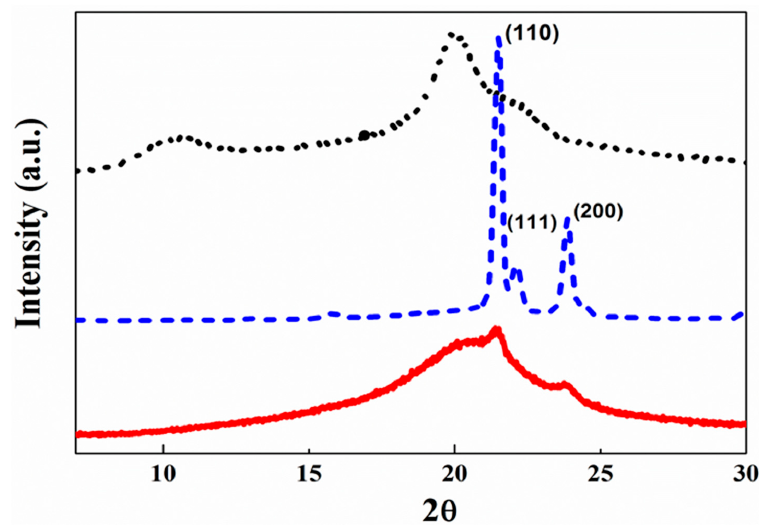
Figure 5. XRD patterns of CS ( ⋯ ), PCL-COOH ( – – – ), and CS- g -PCL ( — ).